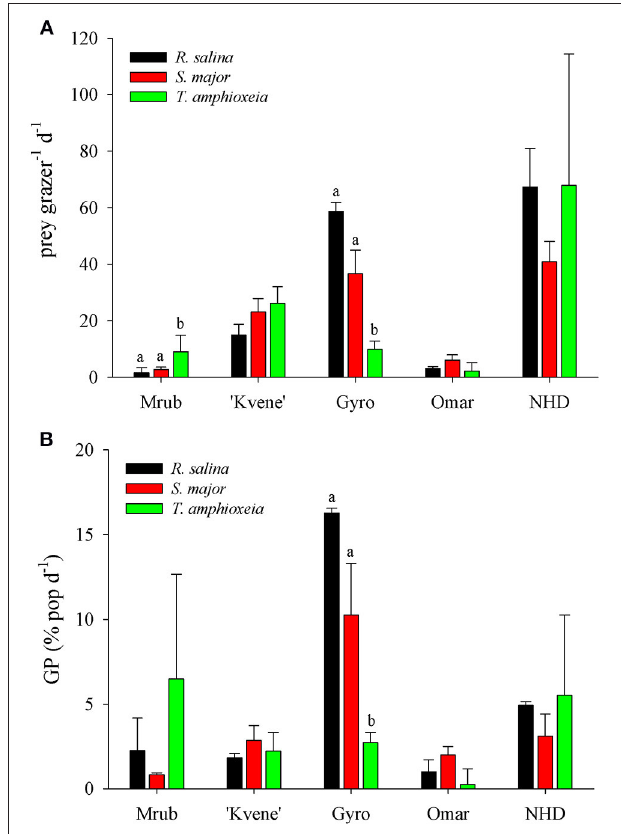
FIGURE 4 | Grazing by phagotrophic protists on three species of cryptophytes. (A) Ingestion rates (IR) of Mesodinium rubrum (Mrub), a Karlodinium veneficum -like dinoflagellate (“Kvene”), a Gyrodinium sp. (Gyro), Oxyrrhis marina (Omar), and an unidentified naked heterotrophic dinoflagellate (NHD) on Rhodomonas salina , Storeatula major and Teleaulax amphioxeia . (B) Grazing potential (GP) on cryptophyte populations. Same information as in (A) . Significant differences between IR and GP on different prey indicated by